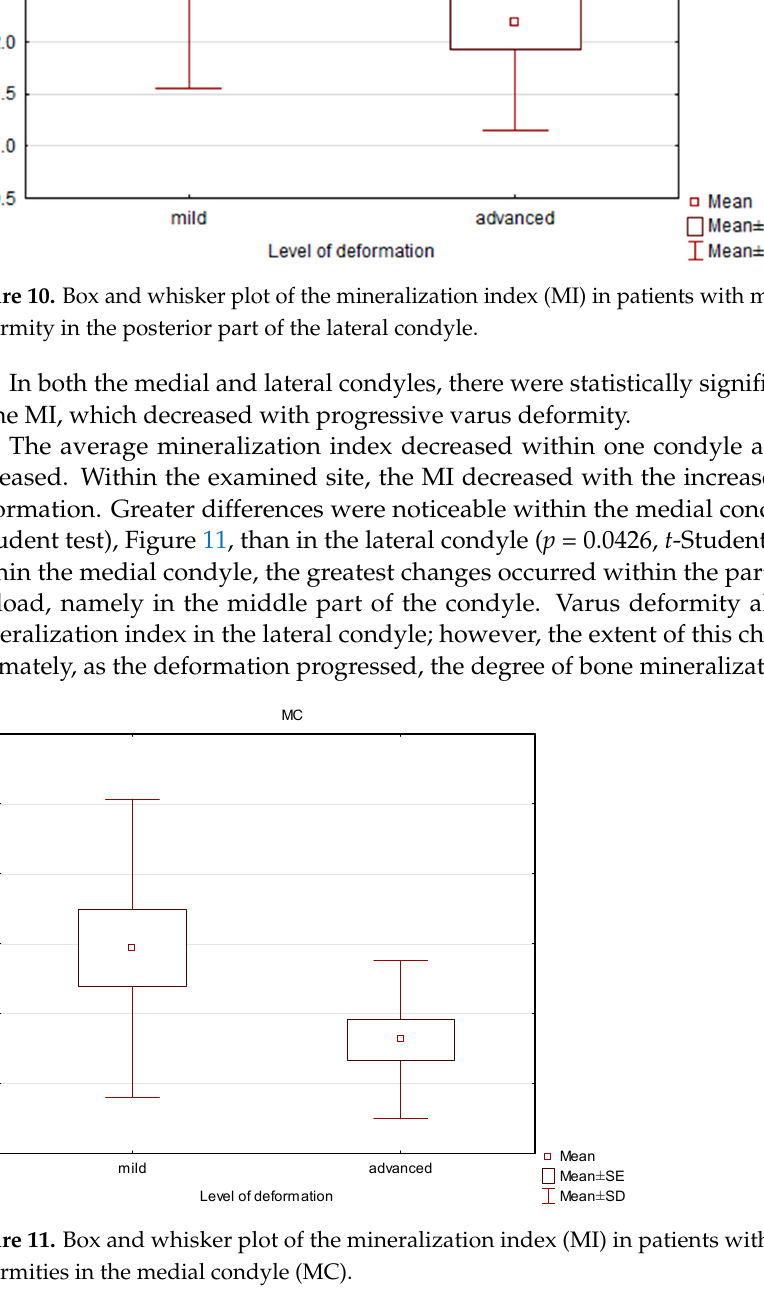
Figure 12. Box and whisker plot of the mineralization index (MI) in patients with mild and severe deformities in the lateral condyle (LC). In the subsequent stages of degenerative changes, there was a decrease in the level of mineralization in both tibial condyles, as shown in Figure 13 (NIR post hoc test), referring to the medial condyle and Figure 14 (NIR post hoc test), referring to the lateral tibial con- dyle.